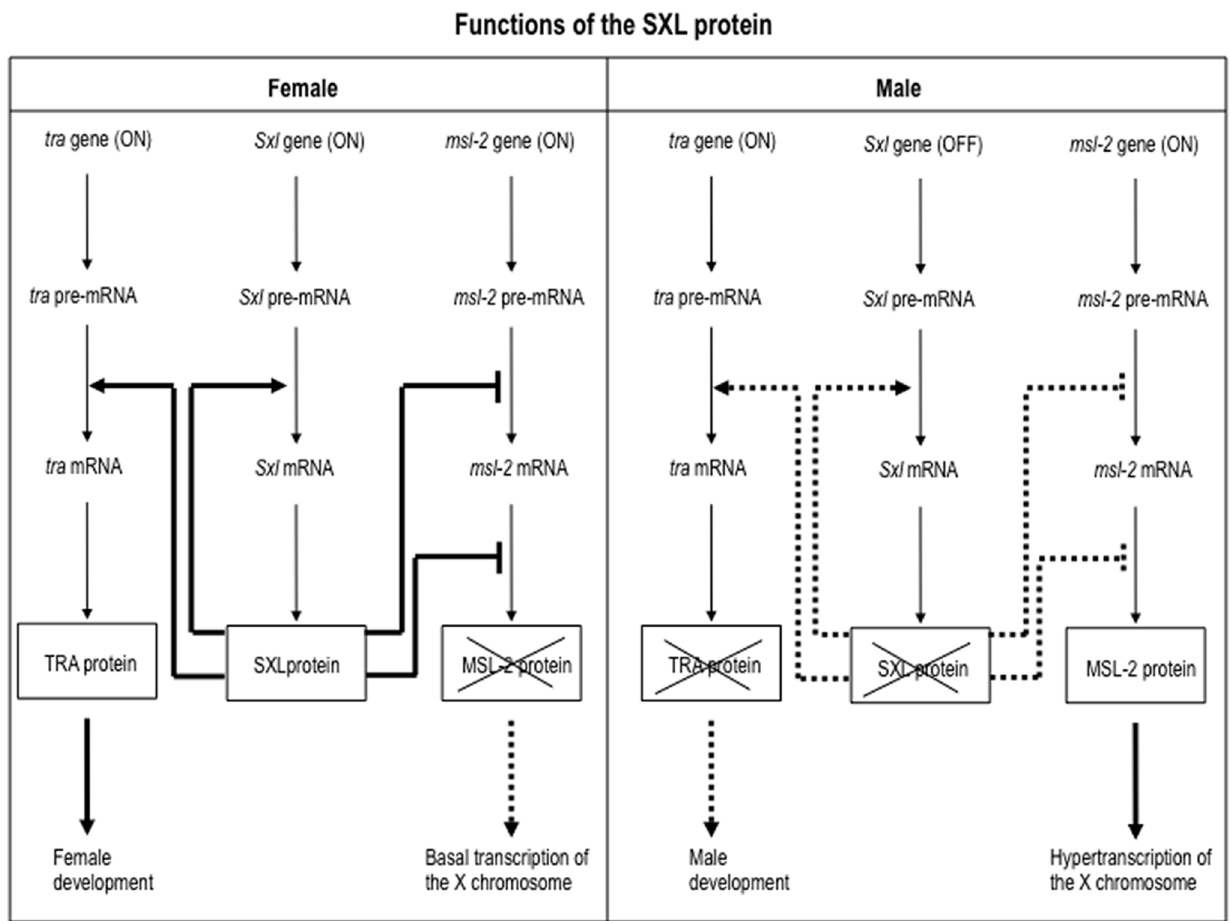
Figure 1. Scheme showing the sex-specific functions of the Drosophila SXL protein. Normal and dashed lines indicate active and inactive interactions, respectively. The crossed boxes for SXL, TRA and MSL-2 proteins designate lack of these proteins. After blastoderm stage, Sxl begins to function in both sexes, and production of the Sxl transcripts persist throughout the remainder of development and adult life. The male-specific transcripts are similar to their female-specific counterparts, except for the presence of an additional exon (exon 3), which contains translational stop codons. Consequently, male transcripts give rise to presumably inactive truncated proteins. In females, this exon 3 is spliced out and functional SXL protein is produced [67,68]. The gene tra is transcribed in both sexes but its pre-mRNA follows an alternative splicing. In males, exon 2 introduces a translational stop codon, leading to the production of a truncated, presumably non-functional TRA protein. In females, however, approximately half of the tra pre-mRNA is spliced differently due to the intervention of the SXL protein, so that the RNA fragment on exon 2 containing the translation stop codon is not incorporated into the mature mRNA encoding the whole, functional TRA protein [6–10]. The gene msl-2 is transcribed in both sexes but its pre-mRNA follows an alternative splicing. In females, the SXL protein prevents the splicing of an exon at the 5 9 UTR, which introduces SXL- binding sequences [13–16]. Consequently, SXL binds to these sequences and to those located at the 3 9 UTR inhibiting the translation of the msl2- mRNA and then MSL2 protein is not synthesised [69,70]. In males, however, the exon at the 5 9 UTR is spliced out and MSL2 protein is